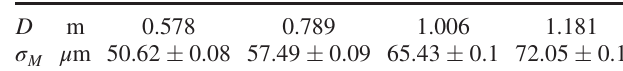
TABLE IV. The beam sizes measured during the dispersion scan, V ¼ 0 . 61 MV.